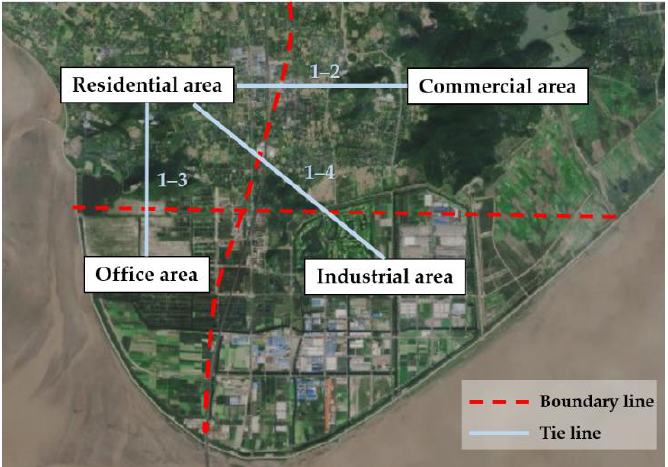
Figure 6. The integrated electricity and heating system in a certain region in China. Table 1. Power configuration of each functional area.